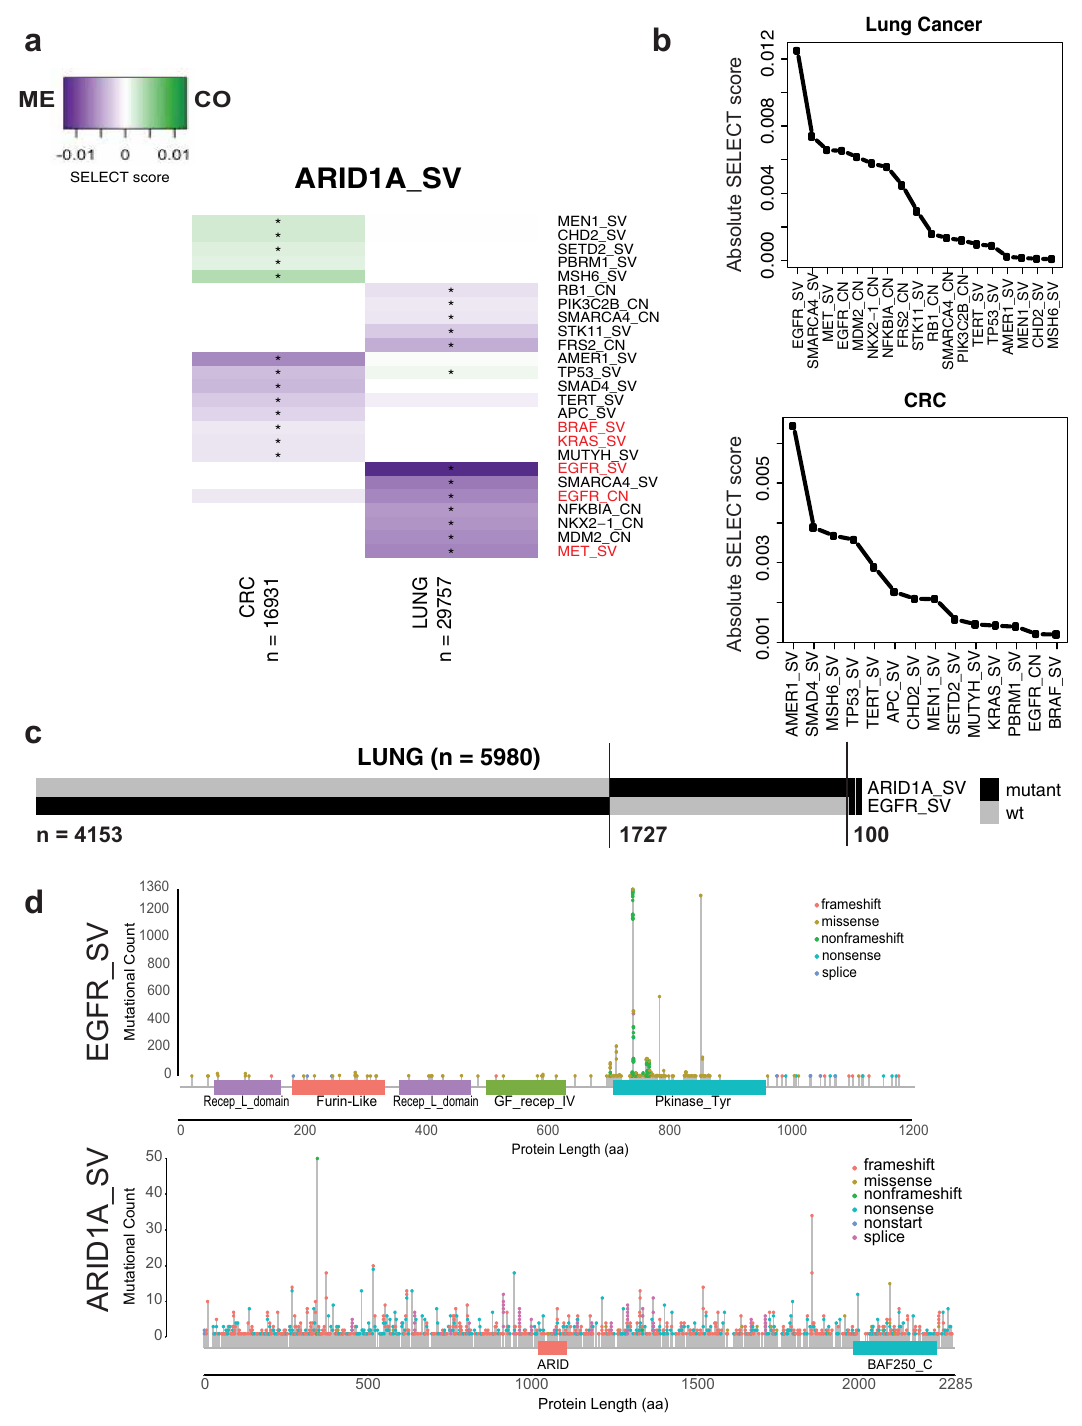
Fig. 4 | ARID1A mutations may compensate for mutant EGFR signaling by partially inducing an EGFR transcriptional program. a Overview of genes with SV or copy-number alterations (CN) that are mutual exclusive (ME, purple) or co- occurring (CO, green) with ARID1A SVs based on the SELECT method 32 , in a CRC ( n =16,931) and lung cancer ( n =29,757) cohort from the FMI FoundationCORE database 38 . Known and likely oncogenic alterations in each gene were considered